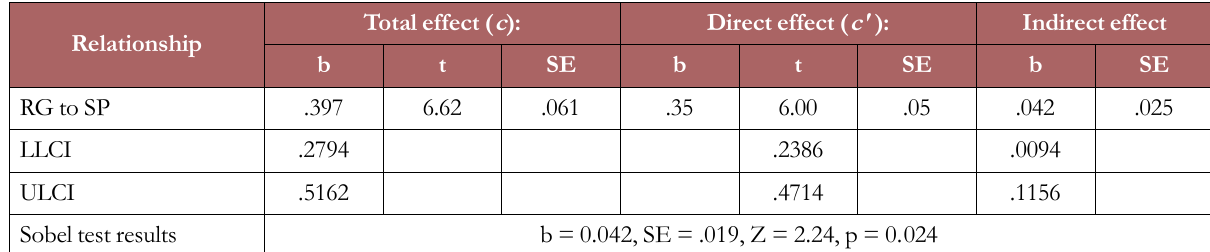
Table 4. Direct, and indirect effects of RG on Social performance through Meta-cognitive CQ